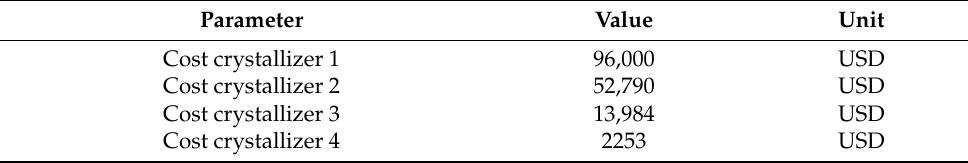
Table 11. Economic results for the multi-crystallization system for 1000 kg/h of feed